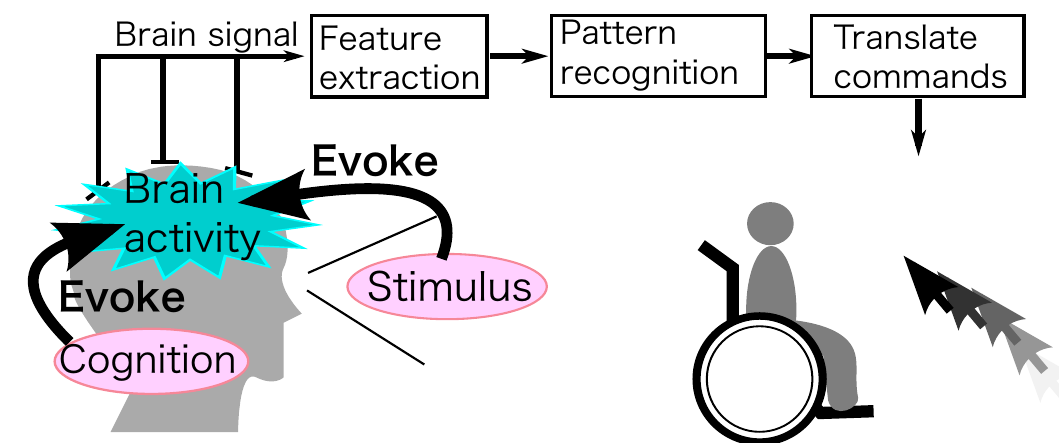
Figure 2. Basic brain–computer interface (BCI) schematic: How targeted brain oscillation signals (or brainwaves ) originate from a visual stimulus or a cognitive process and how they get acquired, processed, and translated into